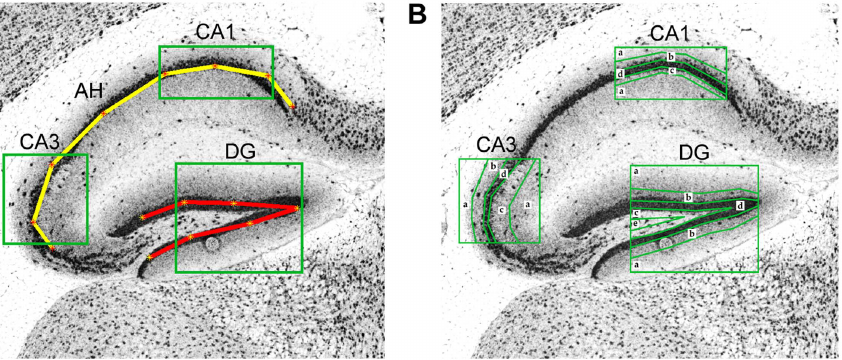
Figure 2. Graphical illustration of the localization and segmentation steps. (A) The deformable model of the Ammon’s horn (AH) and of the dentate gyrus (DG) are represented by a yellow line connecting red stars and by a red line connecting yellow stars, respectively. Selection of the regions of interest is represented by green boxes. (B) The regions described in Table 1 are indicated. doi:10.1371/journal.pone.0074481.g002 PLOS ONE |